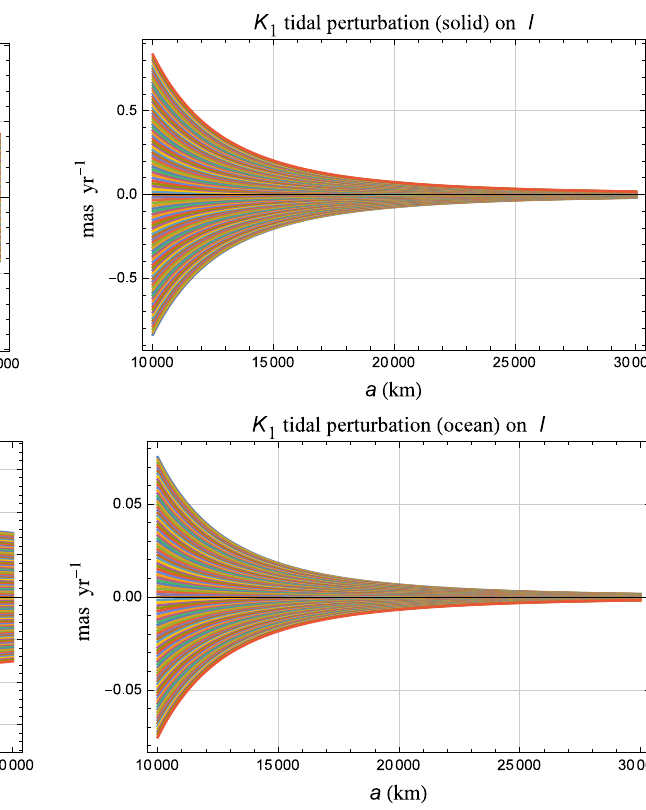
Fig. 3 Nominal amplitudes, in mas year − 1 , of the rates of change of the satellite’s inclination I induced by the solid (upper row) and ocean prograde(lowerrow)componentsofthe K 1 tidefor (cid:5) = 2 , m = 1 , p = 1 , q = 0 from Eqs. (17) to (18) as a function of the semimajor axis a for different values of I in the range I = 90 ± 5 × 10 − 3